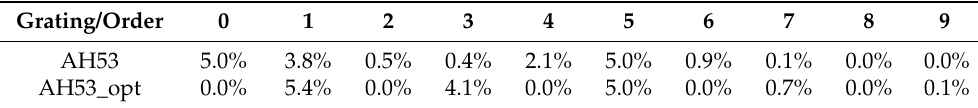
Table 3. Comparison the efficiency of each order for AH53 and AH53_opt.